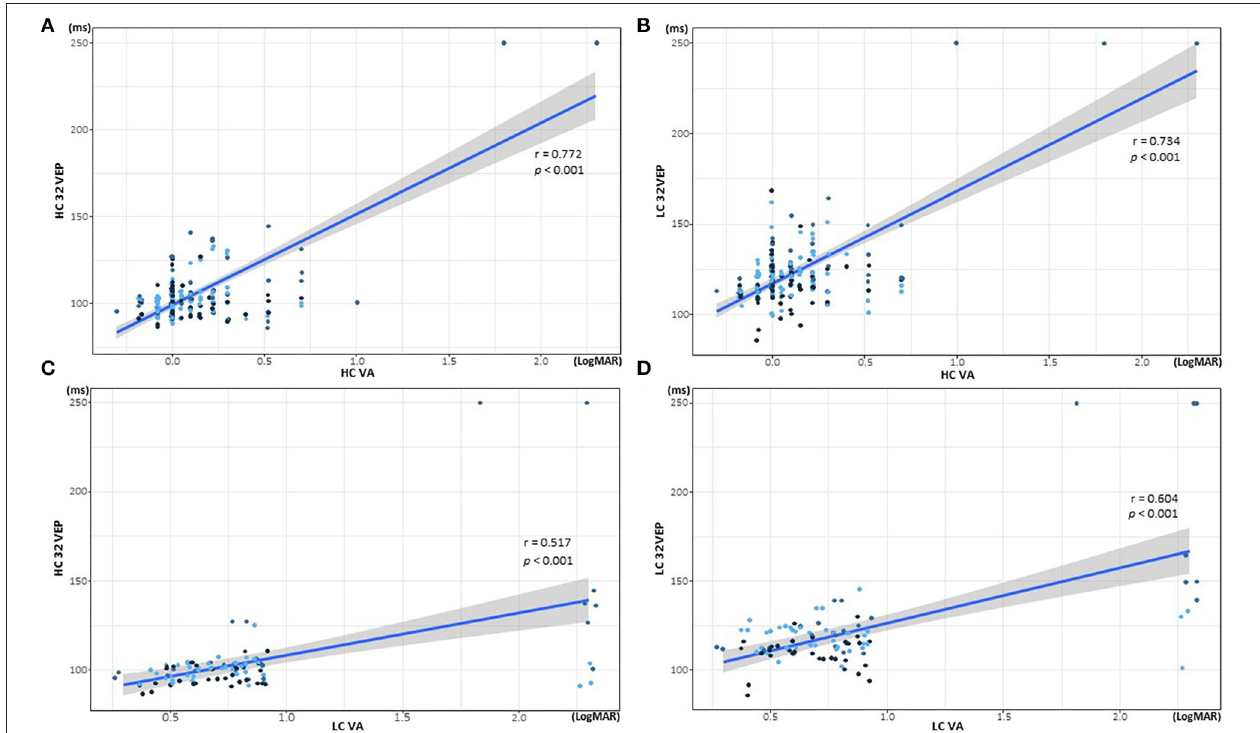
FIGURE 4 | Correlations of visual acuity (VA) and visual evoked potential (VEP) latency according to contrast stimuli. (A) Correlation of high-contrast (HC) 32 VEP and HCVA. (B) Correlation of low-contrast (LC) 32 VEP and HCVA. (C) Correlation of HC32 VEP and LCVA. (D) Correlation of LC32 VEP and LCVA.